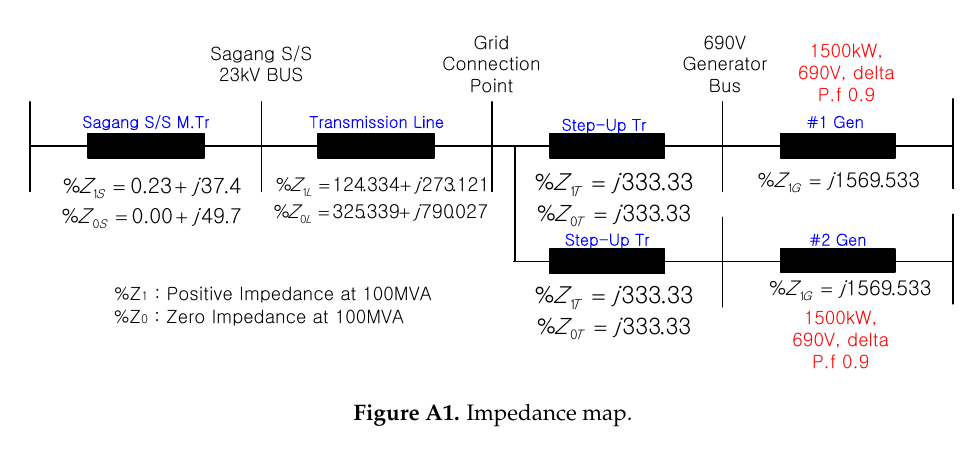
Figure A1. Impedance map.